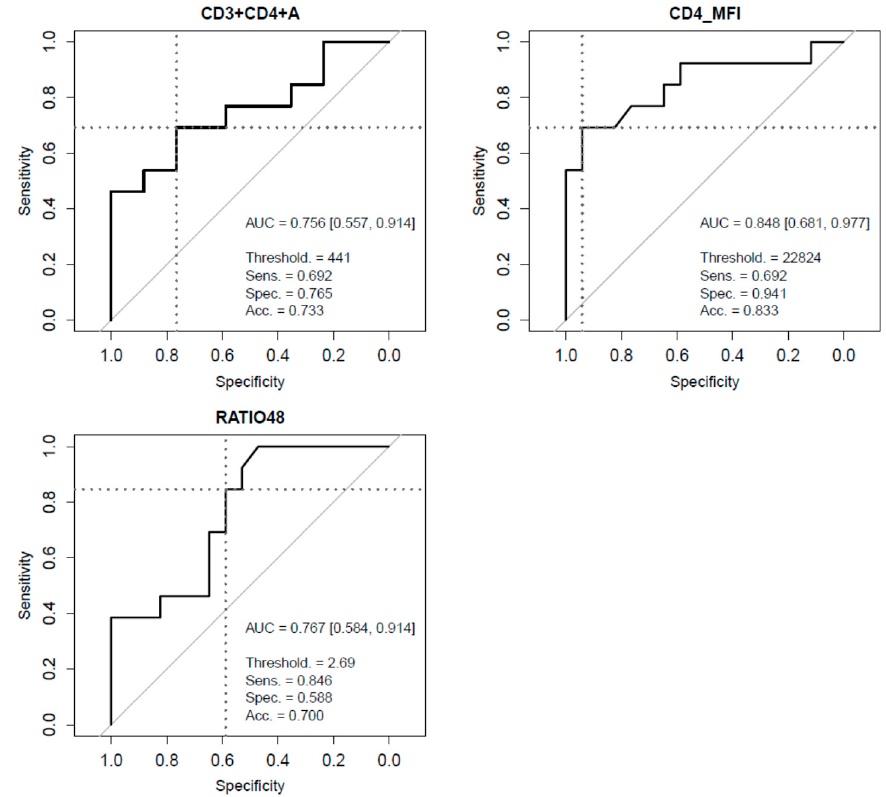
Figure 3. Receiver Operating Characteristics (ROC) and their corresponding Area Under the Curve (AUC) assessing the ability of CD3 + CD4 + T cell count (CD3 + CD4 + A), CD4 + MFI (CD4_MFI) and CD4 +/ CD8 + ratio (RATIO48) to predict COVID-19 critical clinical evolution. AUC intervals at 95% confidence were computed using bootstrap. Total accuracy, sensitivity, and specificity are displayed for the optimal threshold, defined as the ROC point closest to the top-left part of the plot (perfect sensitivity and specificity).